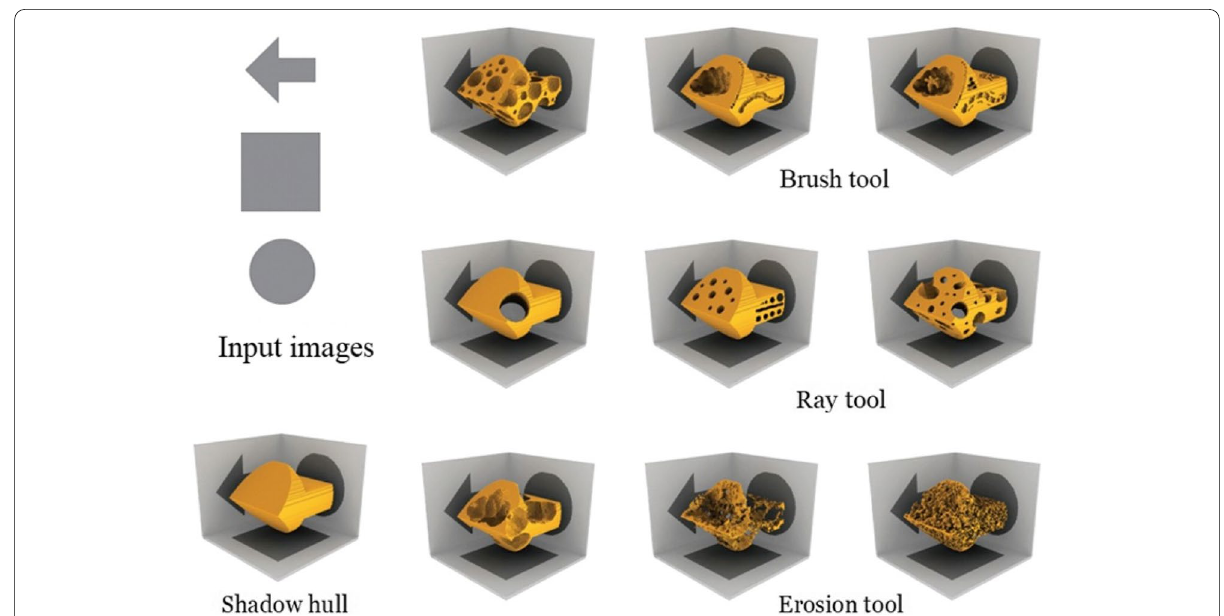
Fig. 1 Mitra and Pauly [2] designed some tools to assist the user in modifying the sculpture without altering the desired shadow images